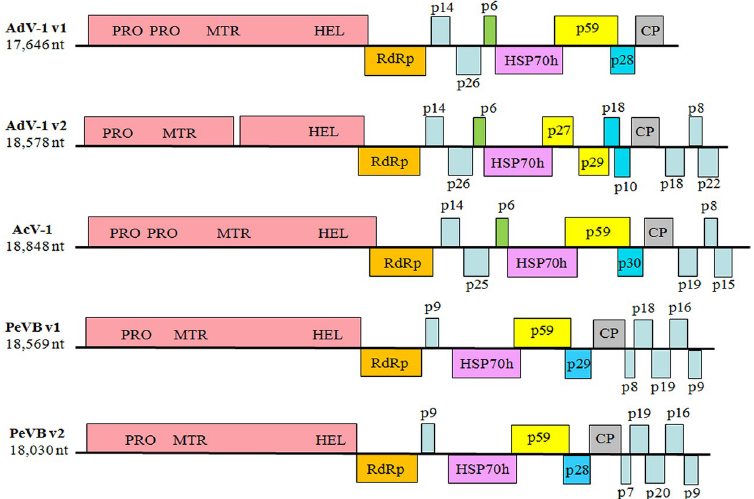
Fig 1. Schematic illustration of the structure of the genomes of AdV-1 variants and other relevant members of the family Closteroviridae . The names of proteins or motifs corresponding to acronyms are as follows: PRO (leader papain-like protease), MTR (methyltransferase), HEL (helicase), RdRp (RNA-dependent RNA polymerase), HSP70h (heat shock protein 70 homolog), CP(coat protein).